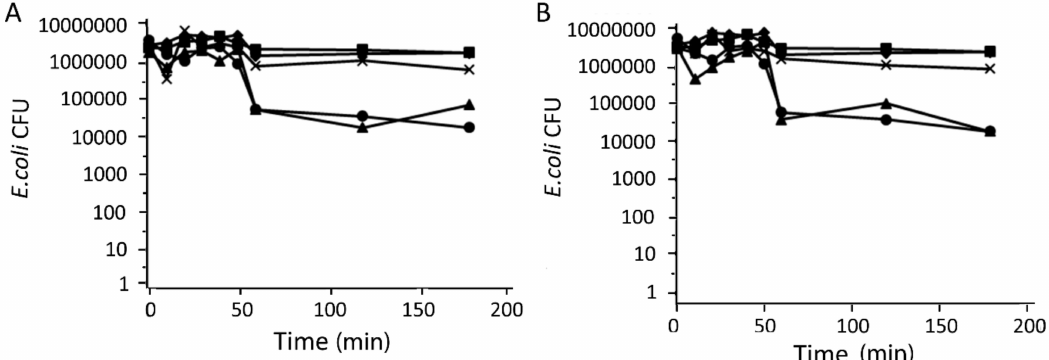
Figure 10. Time-kill curves of LDH1 ( A ) and LDH3 ( B ) composites against E. coli . Cells were untreated in the dark ( − (cid:7) − ) and under irradiation ( − (cid:4) − ); treated with the MIC of LDH1 or LDH3 in the dark ( − × − ) and under irradiation ( − (cid:78) − ); treated with gentamicin in the dark ( − (cid:8) − ) for di ff erent time